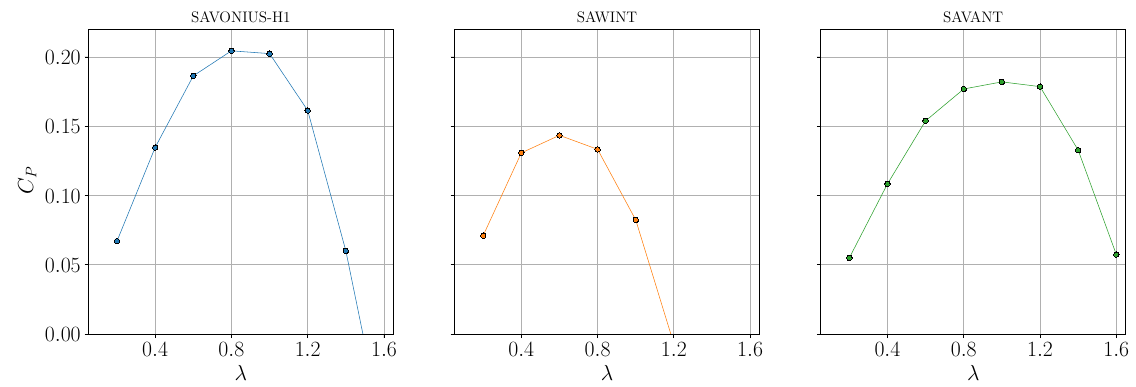
Figure 9. Numerical values of C P as function of λ for SAVONIUS-H1 ( left ), SAWINT ( center ) and SAVANT ( right ) turbines, corresponding to Reynolds numbers values of 6.32 respectively.